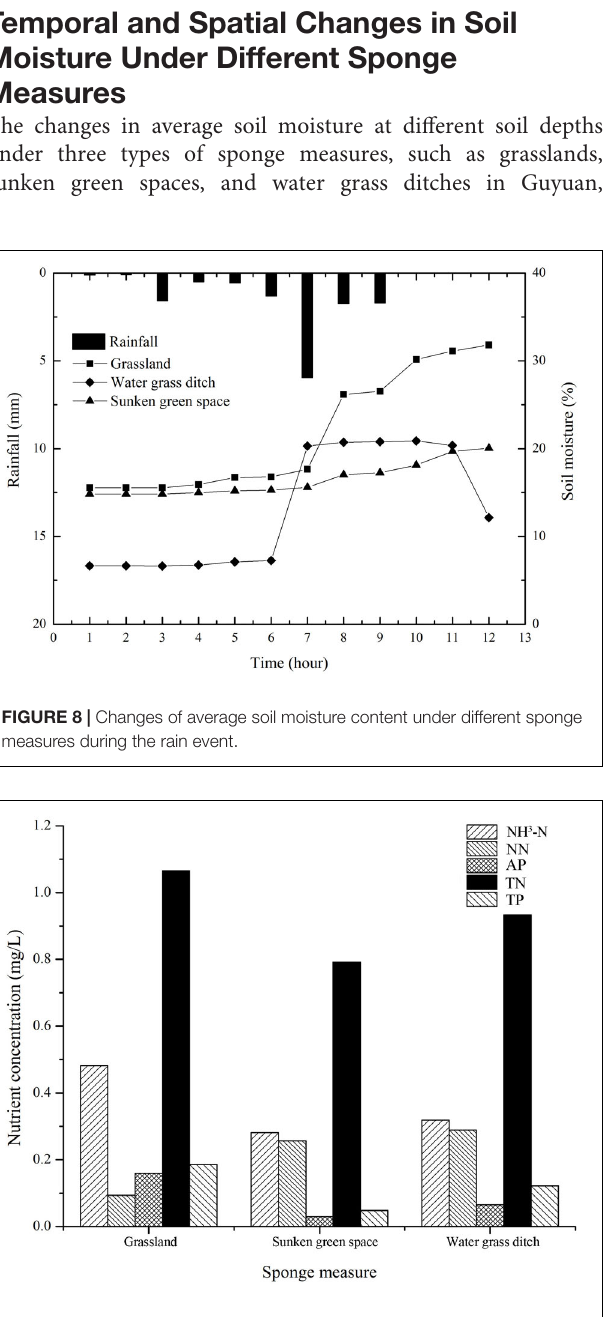
FIGURE 9 | Water quality changes under different sponge measures during the rain